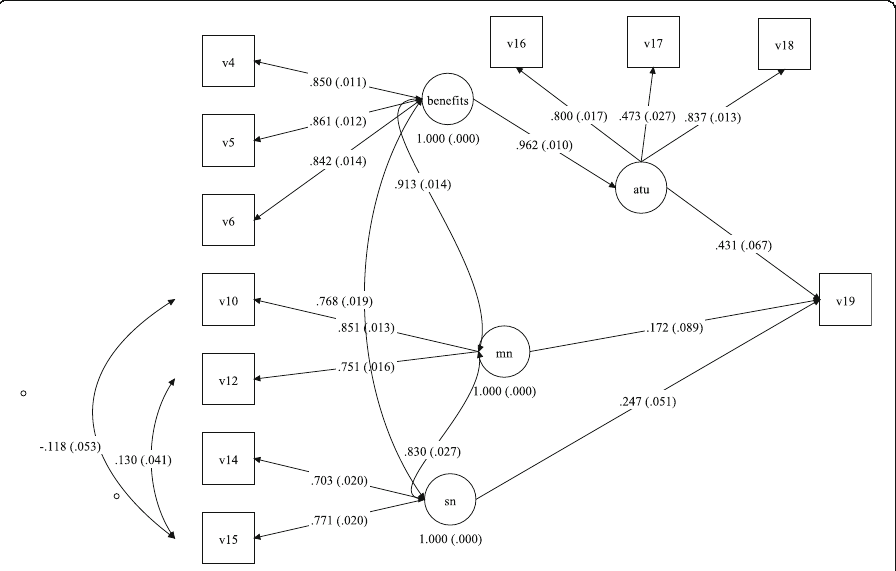
Fig. 9 Final pooled model for ‘ agroforestry ’ . Standardised parameter estimates are shown with associated standard errors in